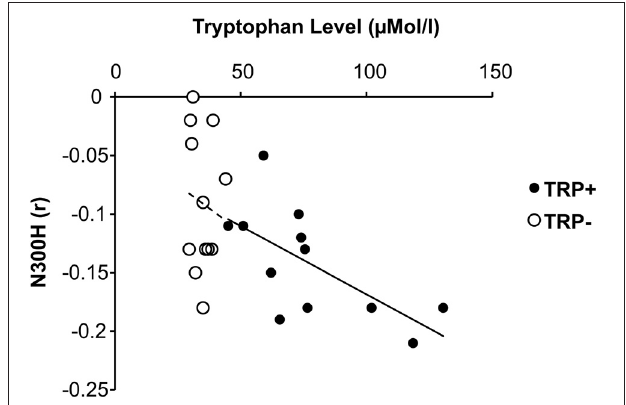
FIGURE 3 | Relationship between plasma tryptophan level and cortico-cardiac connectivity as indicated by peak N300H amplitude under placebo and acute tryptohan depletion